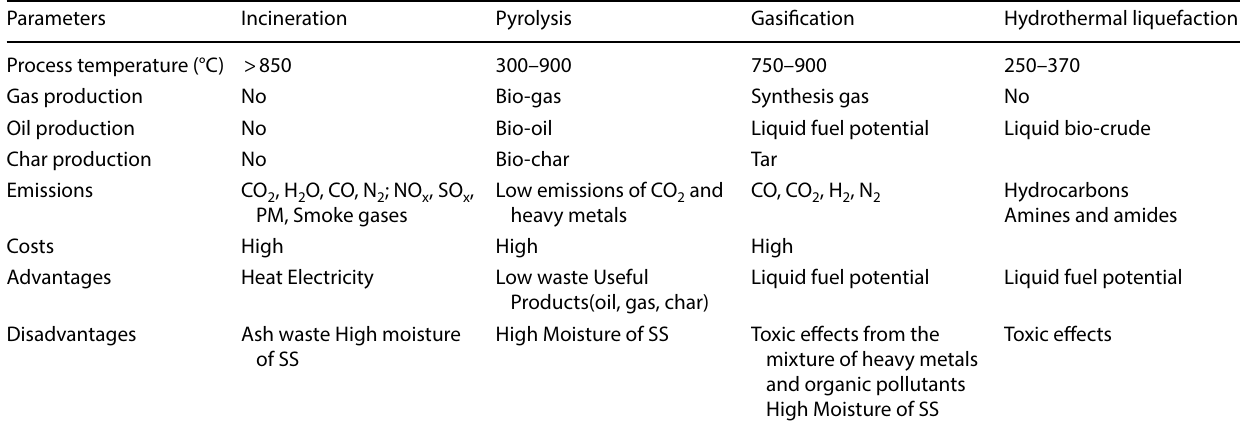
Table 2 Comparison of main characteristics of technologies applied for sewage sludge elimination [74] Parameters